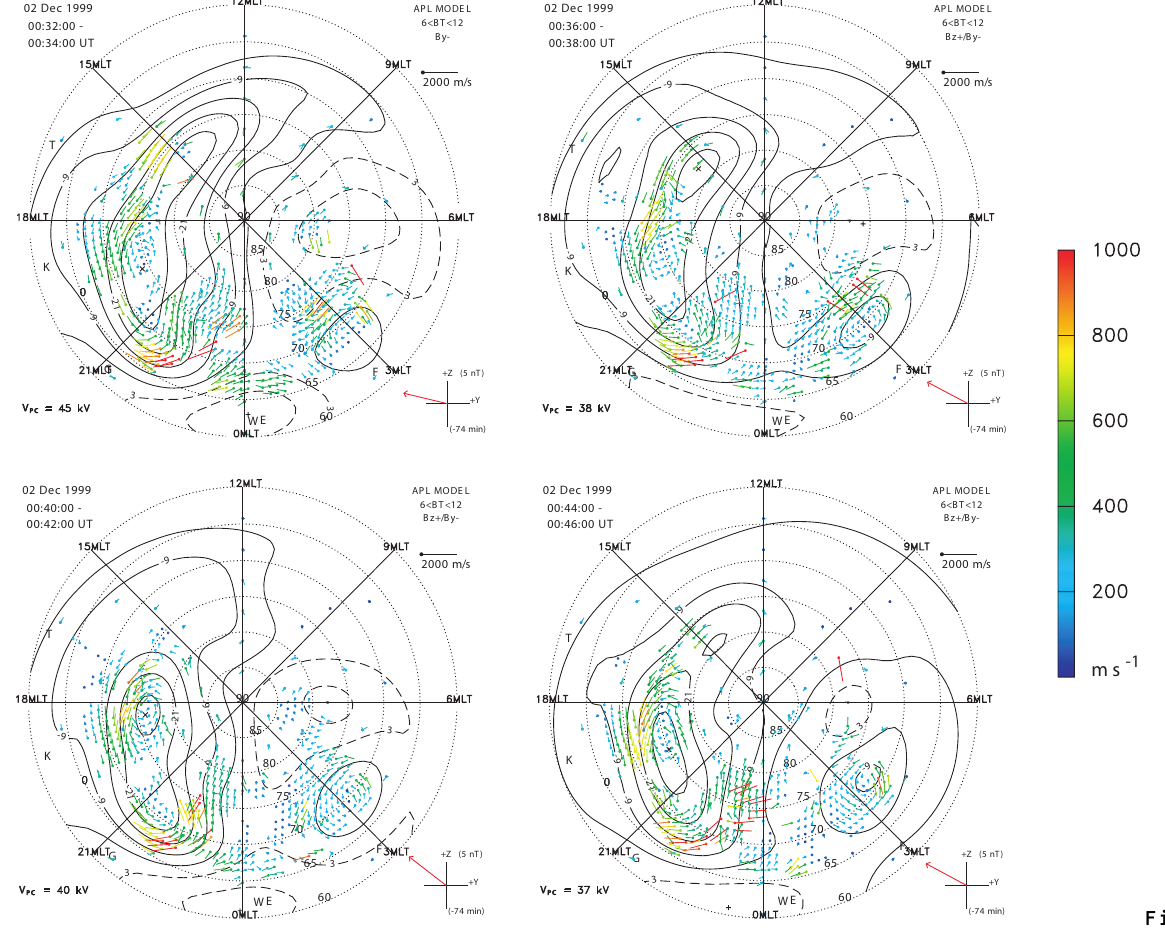
Fig. 6. Streamlines and vectors of the ionospheric flow derived from the six-radar SuperDARN velocity measurements are shown on a geomagnetic grid, obtained from the Map-Potential algorithm (see Sect. 2.1). The intervals displayed are (a) 00:32–00:46UT, (b) 00:48– 01:02UT and (c) 01:04–01:18UT on 2 December 1999. on 2 December 1999. Four maps are shown in each panel (a–c), corresponding to every other 2-min radar experiment cycle. Indicated at the bottom of each map is the total transpolar voltage V PC (left-hand corner), and the direction and magnitude (in the Y − Z plane) of the IMF (right-hand corner). In the top right-hand corner we indicate the flow model employed to stabilize the potential solution in regions where no data are available, obtained from the statistical study of Ruohoniemi and Greenwald